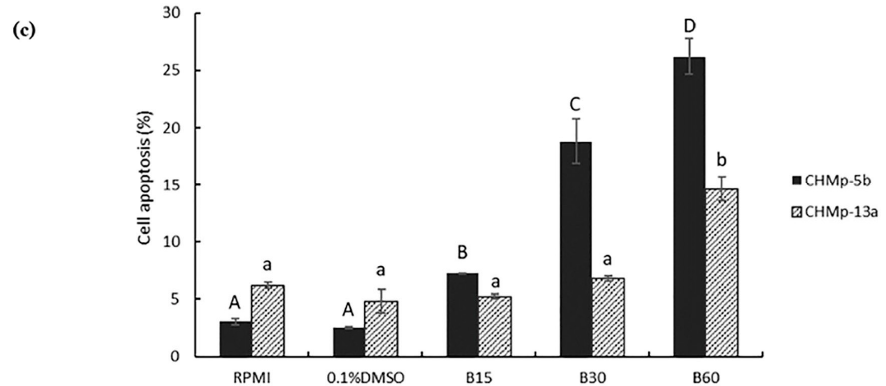
Figure 3. Flow cytometry image of CMGTs in RPMI, 0.1% DMSO and BmKn-2 at 15, 30, 60 µ g/mL at 24 h: ( a ) CHMp-5b; ( b ) CHMp-13a; ( c ) Apoptosis percentages of BmKn-2 at 15, 30 and 60 µ g/mL significantly increased apoptosis percentage in CHMp-5b, the apoptosis percentage of CHMp-13a significantly increased by treating BmKn-2 at 60 µ g/mL where different letters on superscripts between plots representing the statistically significant differences ( p <